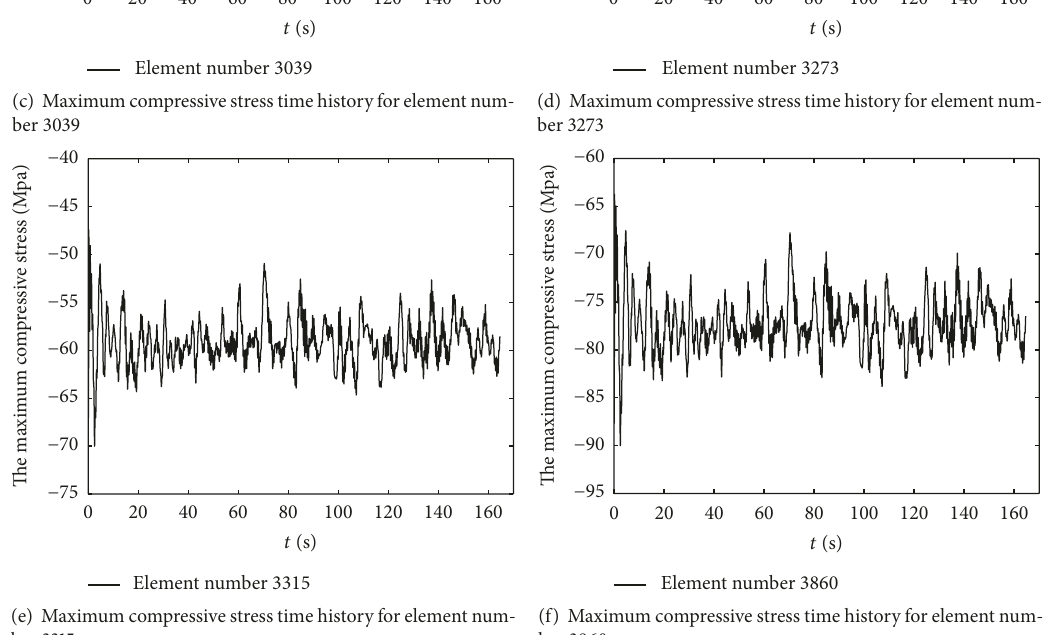
(f) Maximum compressive stress time history for element num- ber 3860